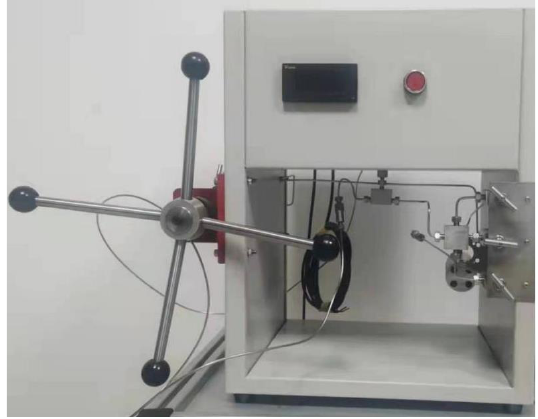
Figure 4. High-pressure water injection device.